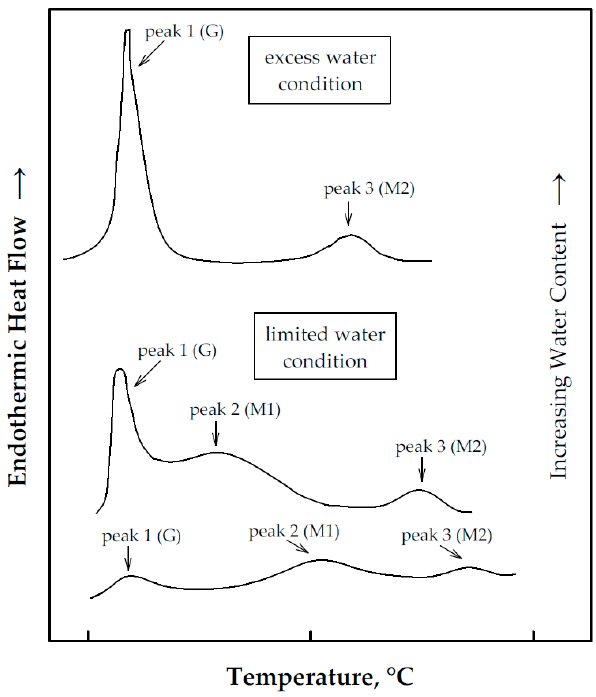
Figure 1. Typical differential scanning calorimetry (DSC) curves of starch/water mixtures at the excess water and limited water conditions. G, M1 and M2 are endotherms. (Redrawn and modified with permission from reference [9]).